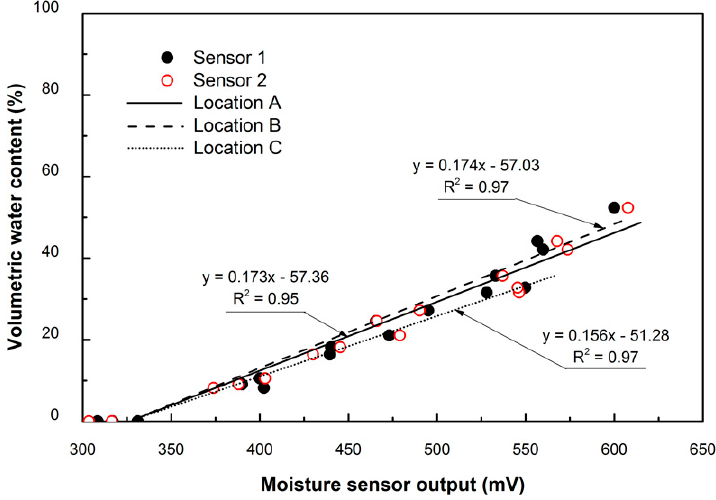
Figure 4. Calibrated results of volumetric water content at three locations (A, B, and C) using two sensors.